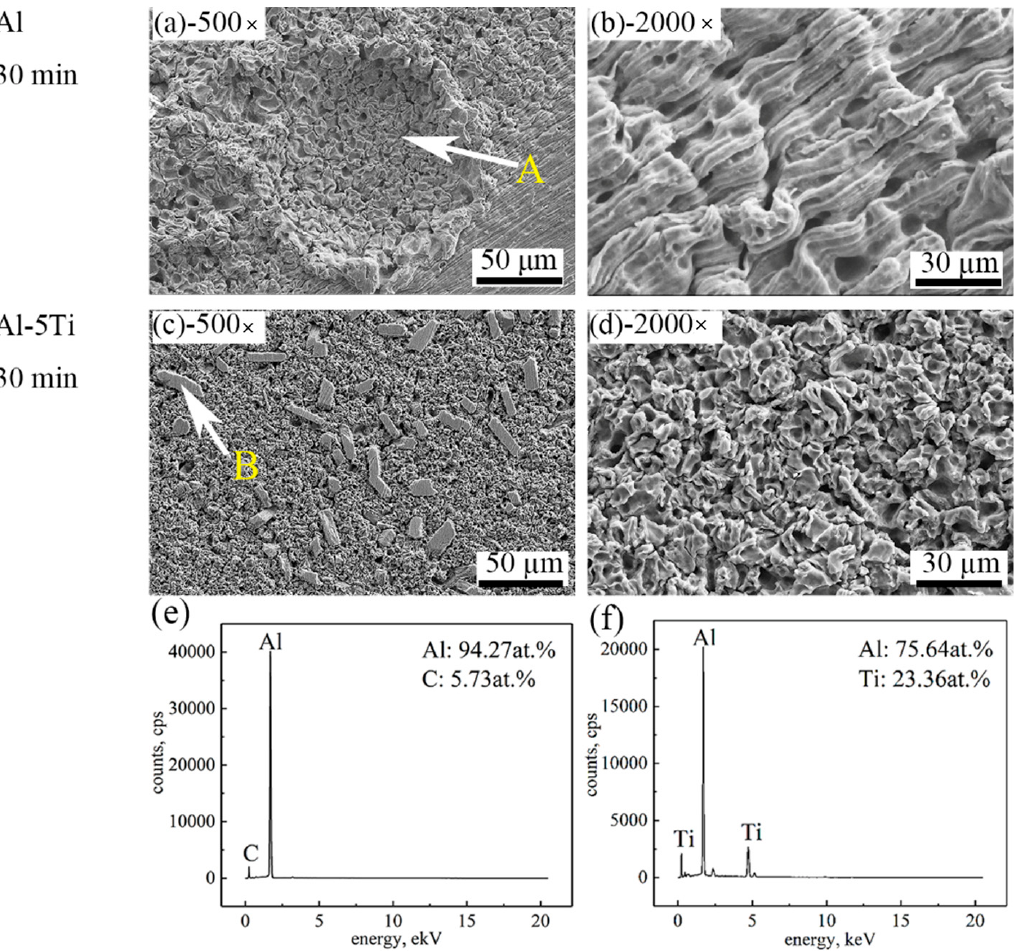
Figure 6. SEM images of different magnification of Al and Al-5Ti alloys after cavitation erosion for 30 min ( a ) 500 × of Al, ( b ) 2000 × of Al, ( c ) 500 × of Al-5Ti, ( d ) 2000 × of Al-5Ti, ( e ) the EDS of point A, ( f ) the EDS of point B.